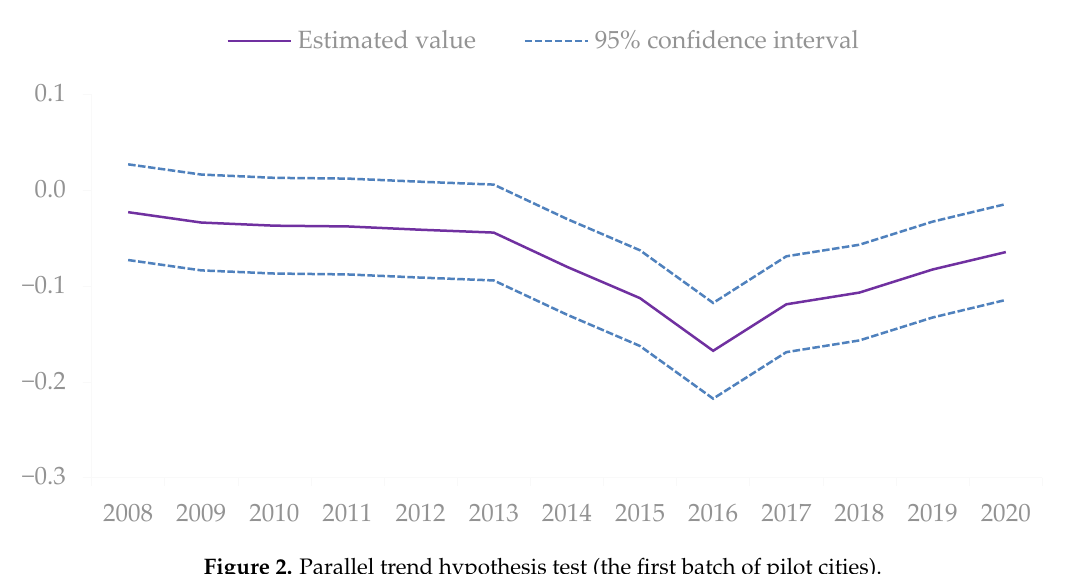
Figure 2. Parallel trend hypothesis test (the first batch of pilot cities).